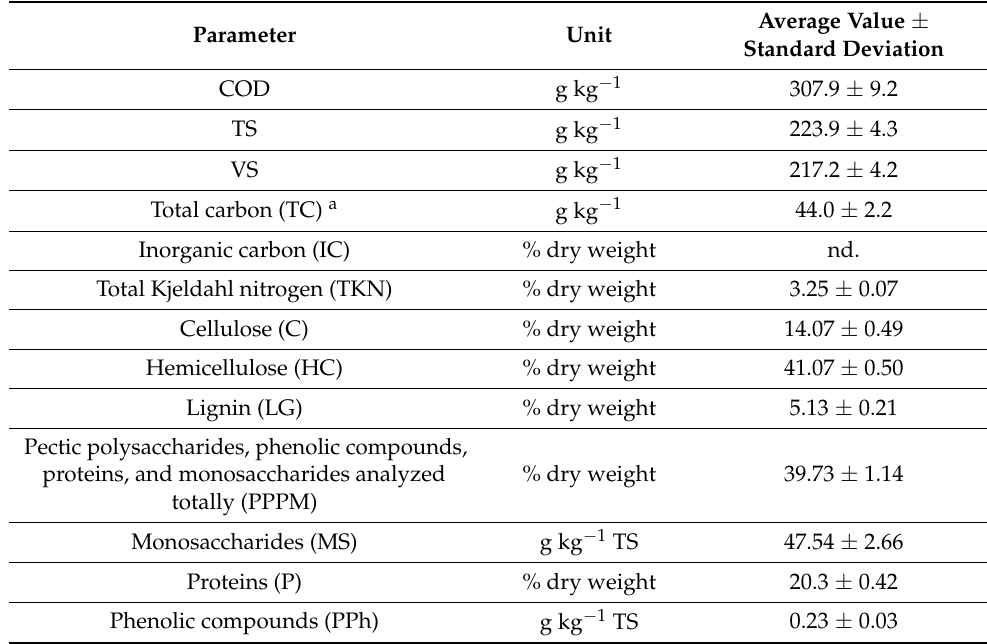
Table 2. Composition of brewery spent grain (BSG) (after its pretreatment by milling) [35].